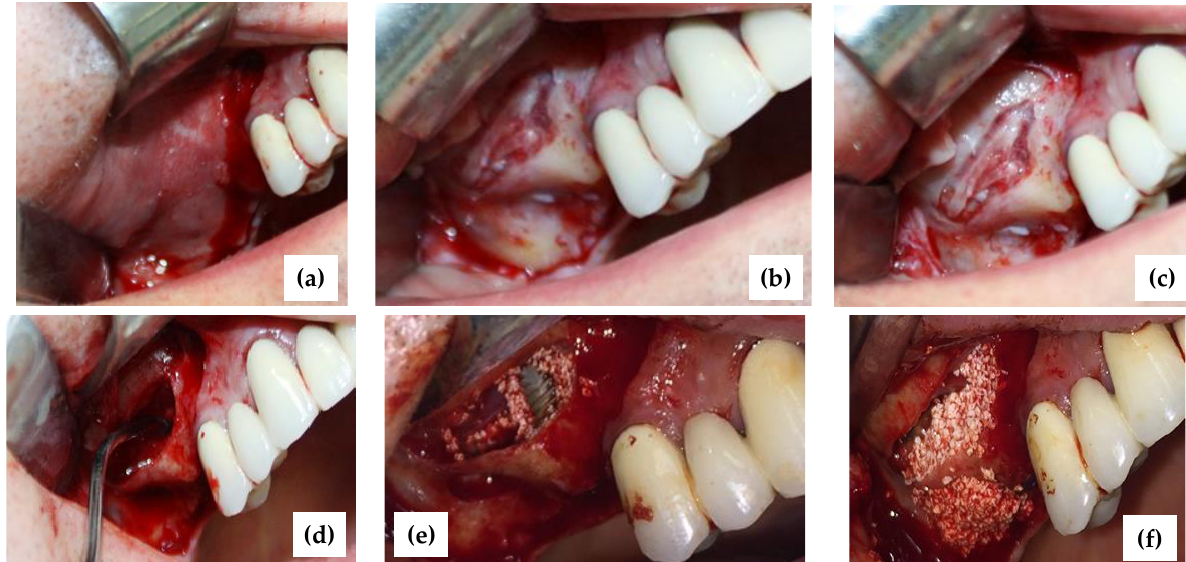
Figure 5. ( a ) Flap design; ( b ) the bony window; ( c ) the bony window, almost completed saving the blood vessels; ( d ) the Schneiderian membrane was elevated; ( e ) inserted implant in the 16 th position with simultaneous sinus augmentation; ( f ) sinus lift procedure 17 and lateral crest augmentation.